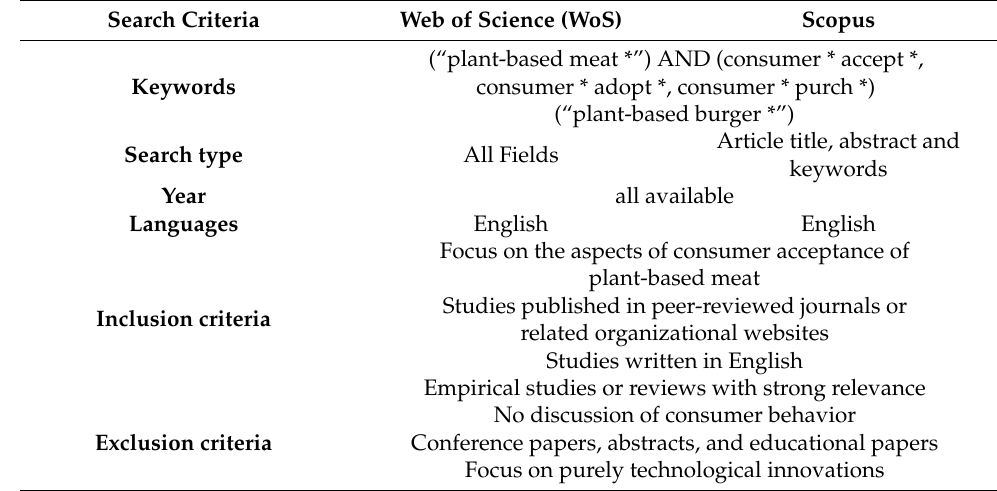
Table 1. Inclusion and exclusion criteria used during the